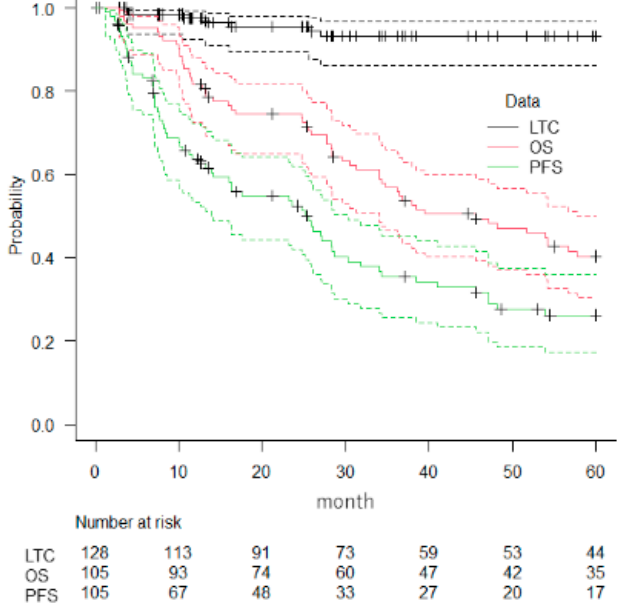
Figure 1. Survival analysis. Kaplan–Meier estimates of local tumor control (LTC), overall survival (OS), and progression free survival (PFS). Dotted lines represent 95% confidence intervals.